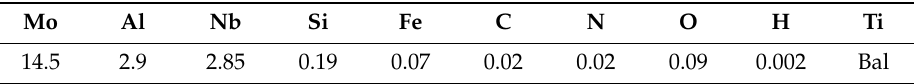
Table 1. Chemical composition of the TB8 titanium alloys (wt.